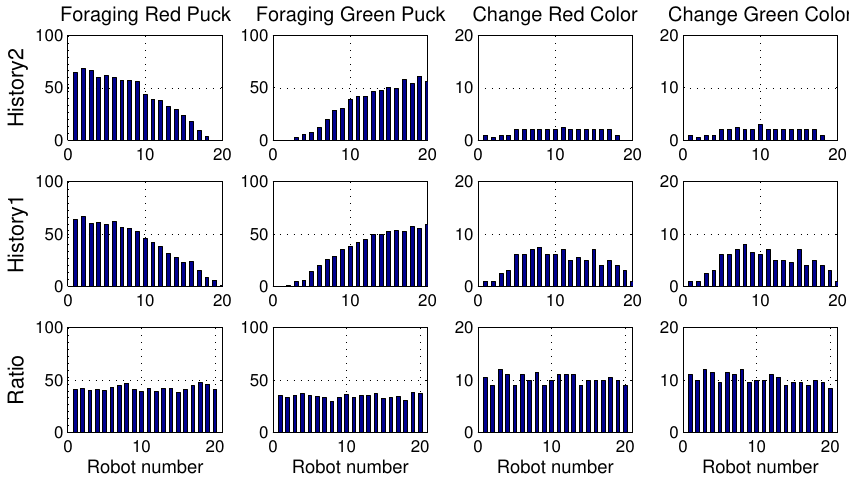
Figure 4. Number of foraged pucks and task changes of an individual